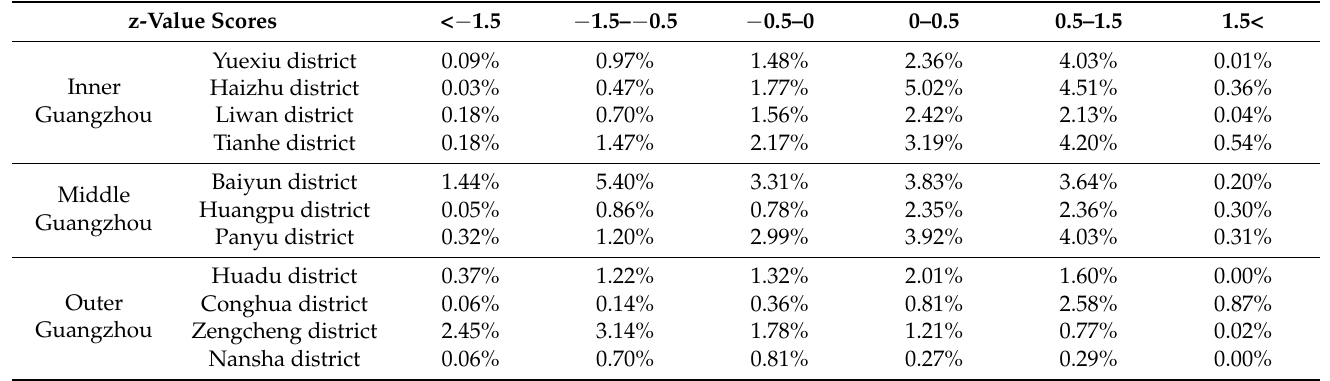
Table 5. The relative improvements in time-based accessibility by population according to districts after rail transit lines were established.